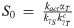
Regulation by intracellular substrate concentrations.Sint can regulate either (A) transporter synthesis (αT) or (B) transporter downregulation (γT). In both cases, we assume this regulation takes the form of a Hill equation with a 'saturation' constant of (A) Ksyn or (B) Kdeg. The saturation constant is the equivalent to the standard disassociation constant but represents the concentration where the system is half saturated for its regulatory potential. For (A) and (B) the diagram on the right uses a hill coefficient (n) of 3, (case of n = 1 is in S1 Appendix, section VII part b, S1 Fig). Higher n leads to more robustness, but global perfect homeostasis is not achievable by any finite value of n. For both (A) and (B), the saturation constants are normalized by S0 = kactαTkγSkγTc.